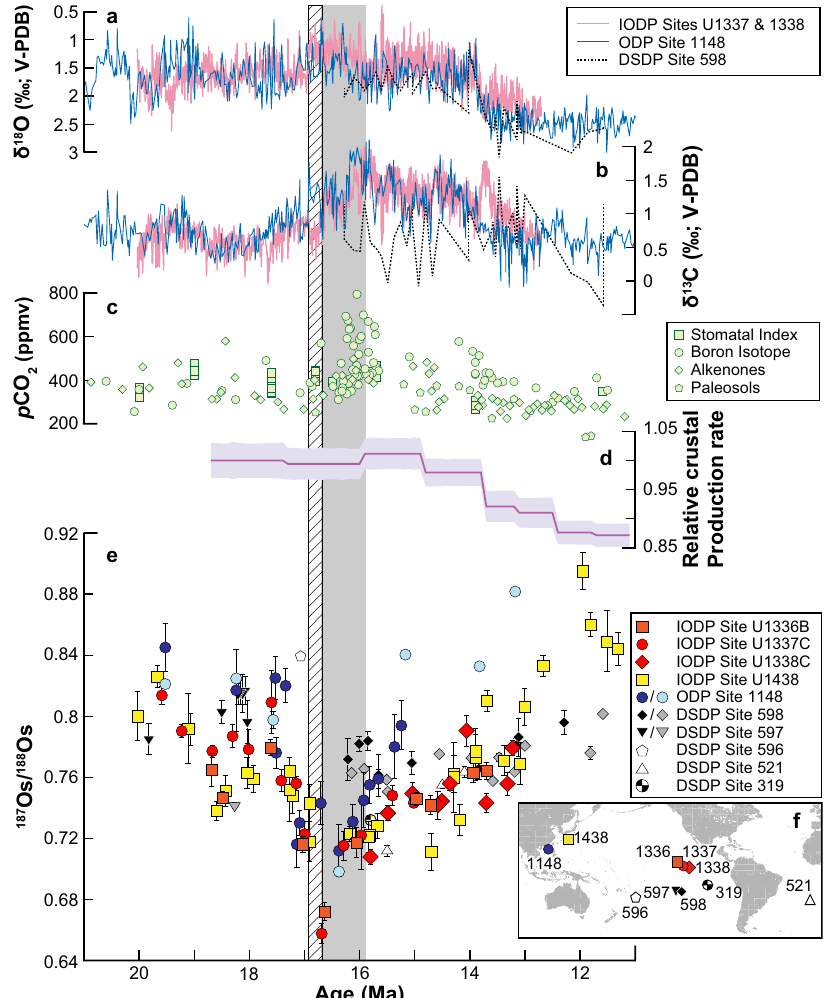
Fig. 1 Geochemical records between 10 and 20 Ma. a Deep-sea δ 18 O 4 – 7,38,42,43 , ( b ) deep-sea δ 13 C 4 – 7,38,42,43 , ( c ) p CO 2 14 – 20 , ( d ) global crustal production rate 26 , ( e ) 187 Os/ 188 Os (errors are 2 SD), and ( f ) map showing locations of studied sites (IODP Sites U1336, 1337, 1338, and 1438, and ODP Site 1148) and previous studied sites (DSDP Sites 319 37 , 521 38 , 596 37 , 597 36,38 , and 598 36,38 ). Atmospheric p CO 2 was estimated based on the density of stomata in fossil leaves 15 , δ 11 B of planktonic foraminifer 16,17,19 , δ 13 C of alkenones 14,20 , and δ 13 C of paleosols 18 . The 187 Os/ 188 Os of ODP Site 1148 and DSDP Sites 597 and 598 are from both the present and previous studies 36,38,39 . The previous 187 Os/ 188 Os data are shown in pale colors. The hatched area in ( a ) ‒ ( e ) shows the period of δ 13 C decline marking the onset of the MCO 5 . The grey area in ( a ) ‒ ( e ) shows the duration of the main eruptive phase of CRB